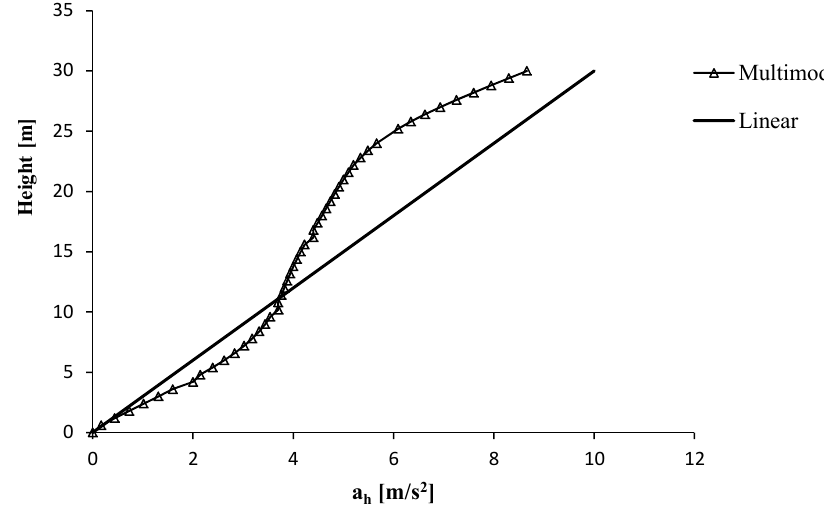
Figure 7. Linear and multimodal acceleration profile.